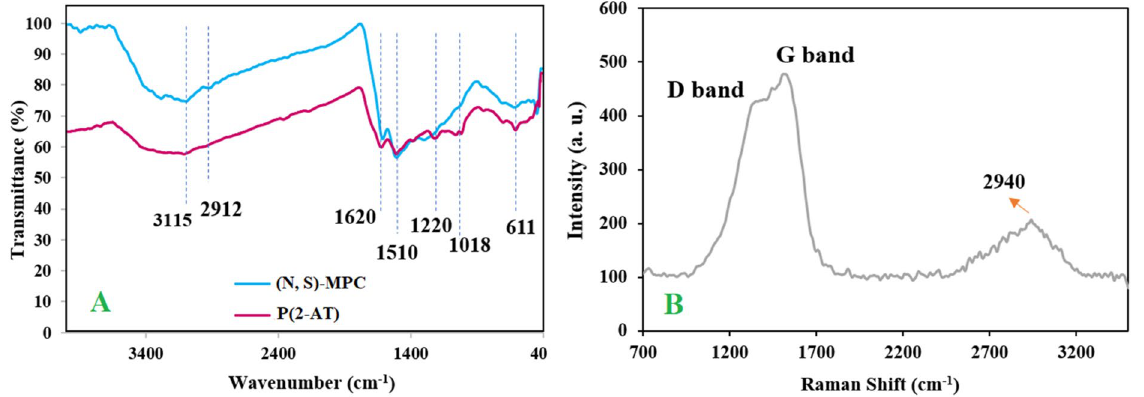
Figure 1. FT-IR spectra of P(2-AT) and (N, S)-MPC ( A ) and Raman spectrum of (N, S)-MPC ( B ).